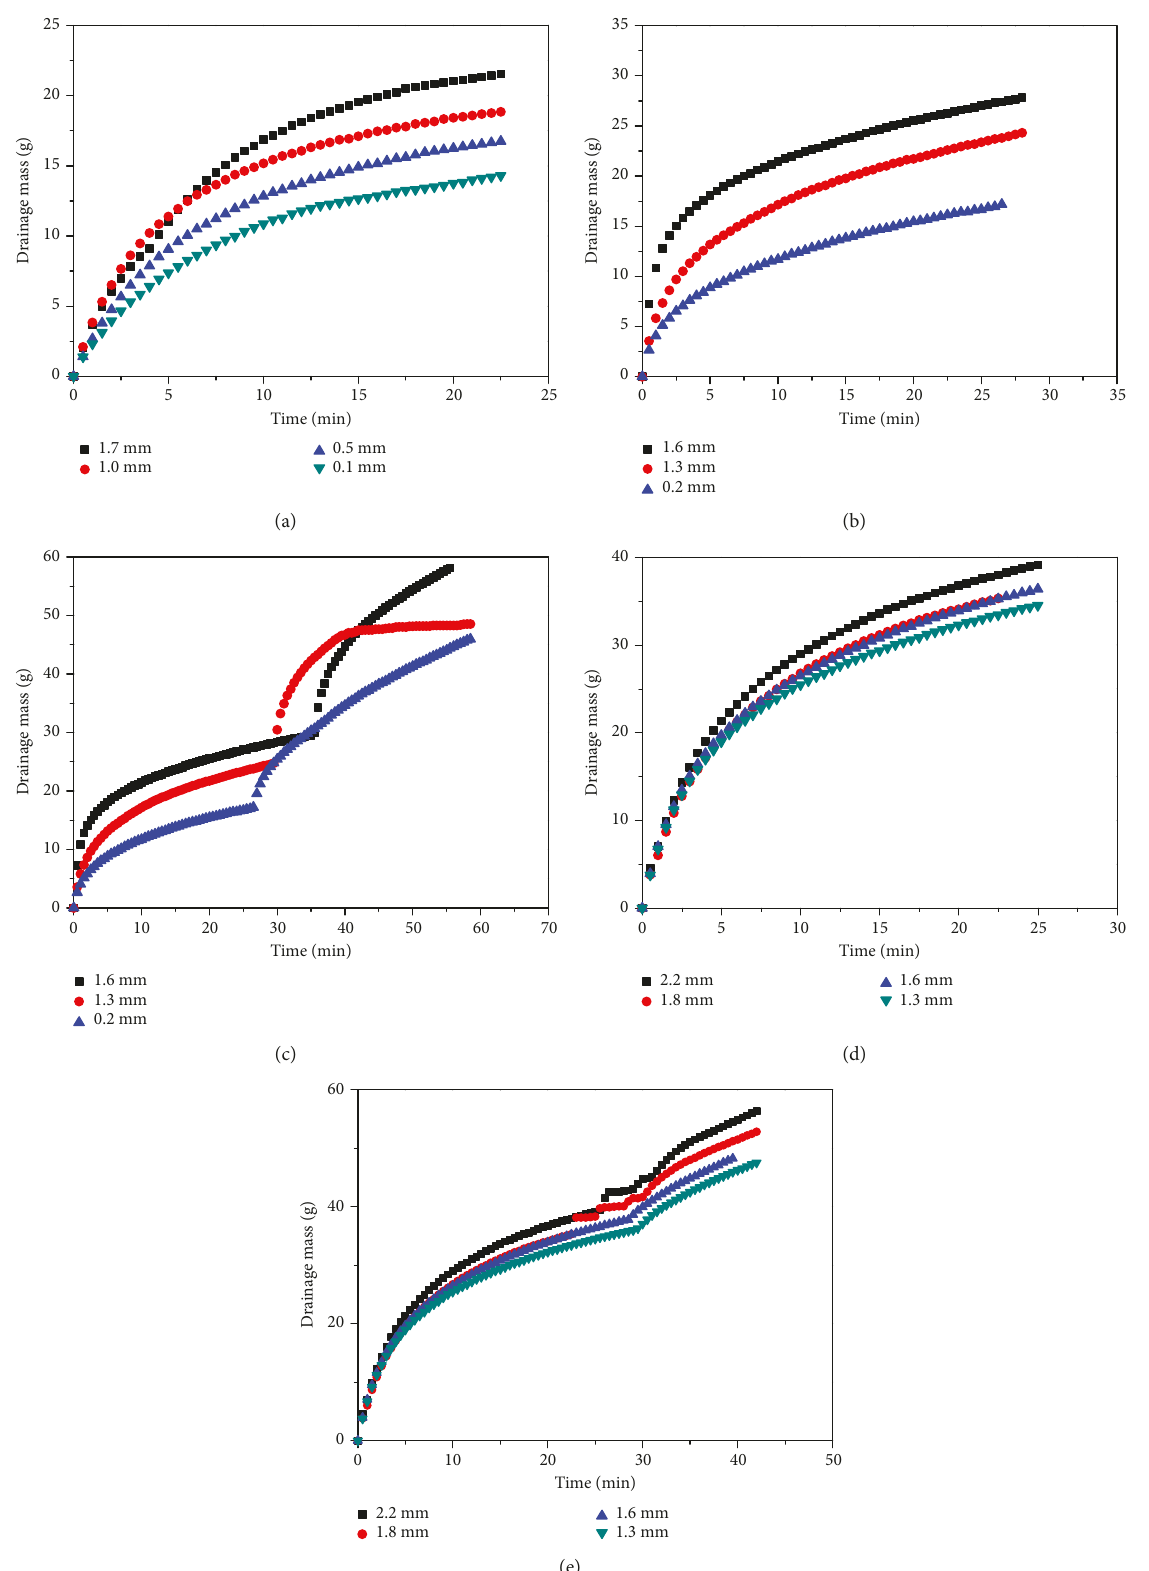
Figure 7: Drainage mass with di ff erent fracture apertures: (a) CI (without gas drive), (b) CII (without gas drive), (c) CII (with gas drive), (d) CIII (without gas drive), and (e) CIII (with gas